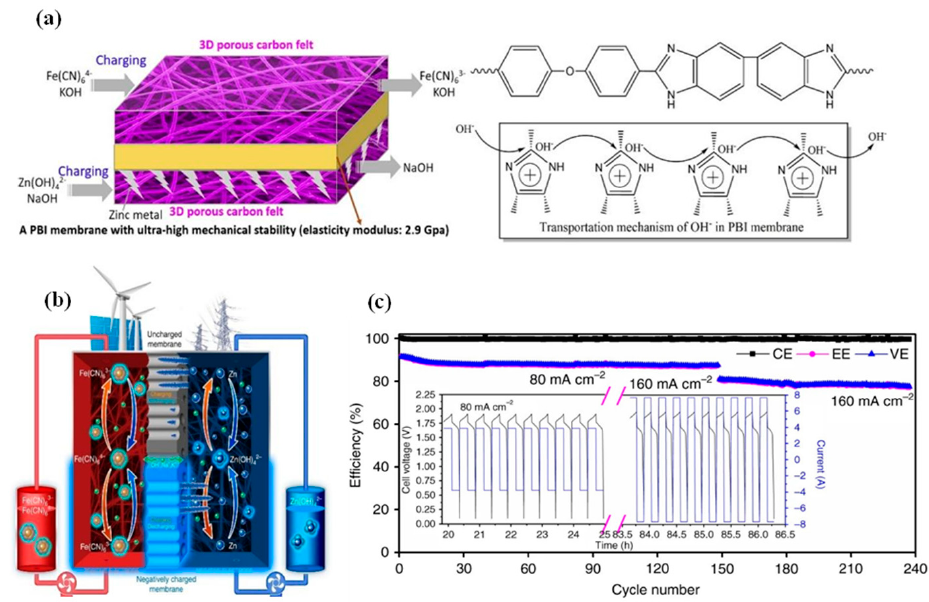
Figure 7. ( a ) Schematic of ZIRFBs adopting a 3D porous CF and PBI membrane with excellent mechanical strength, and the transport principle of hydroxyl ions in the membrane; reproduced with permission from [51]. Copyright 2018, Elsevier. ( b ) Zn accumulation/dendrite of the ZIRFB when adopting the uncharged (up) and the negatively charged (down) porous membrane; ( c ) cycle performance for an alkaline ZIRFB between 80 and 160 mA cm − 2 for 240 cycles; insets: charge–discharge profiles. Reproduced under terms of the CC-BY license [52]. Copyright 2018, Springer Nature.